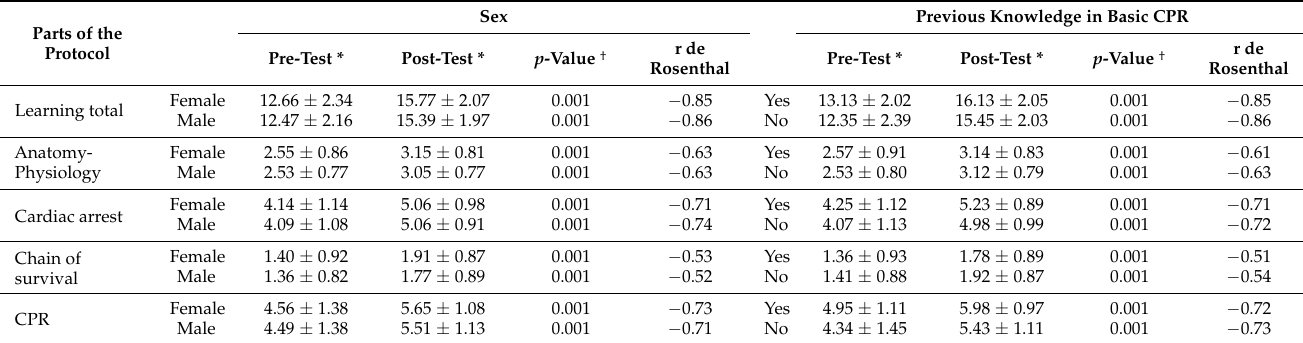
Table 2. Description of pre- and post-test scores by sex and previous knowledge in CPR.